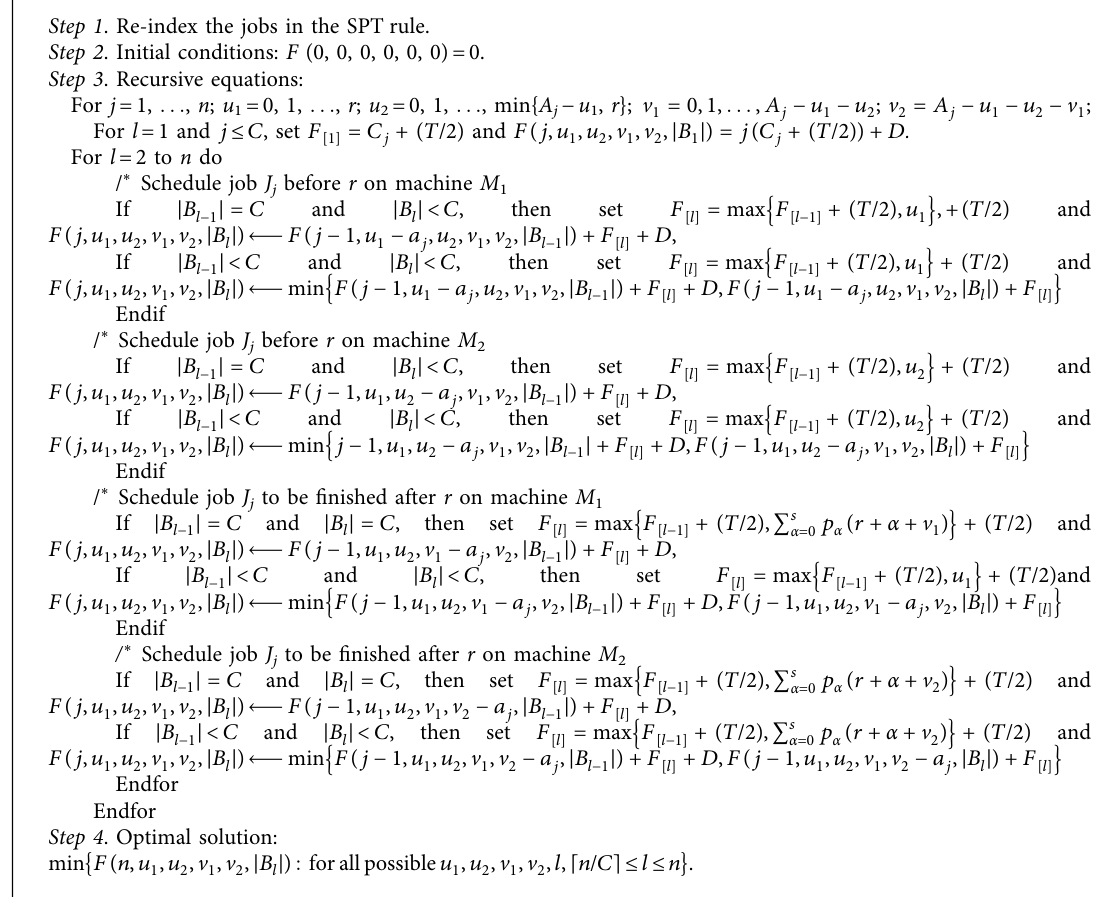
A LGORITHM 3: Algorithm